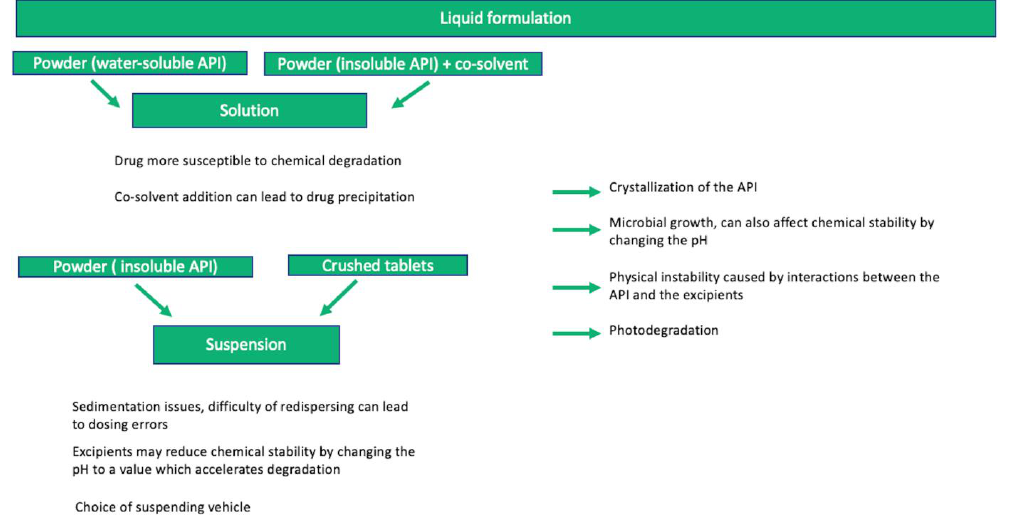
Figure 2. Left-hand side: stability issues for liquid dosage forms depending on the formulation (solutions or suspensions) and the compounding technique, respectively; right-hand side: common stability issues for liquid oral dosage forms.